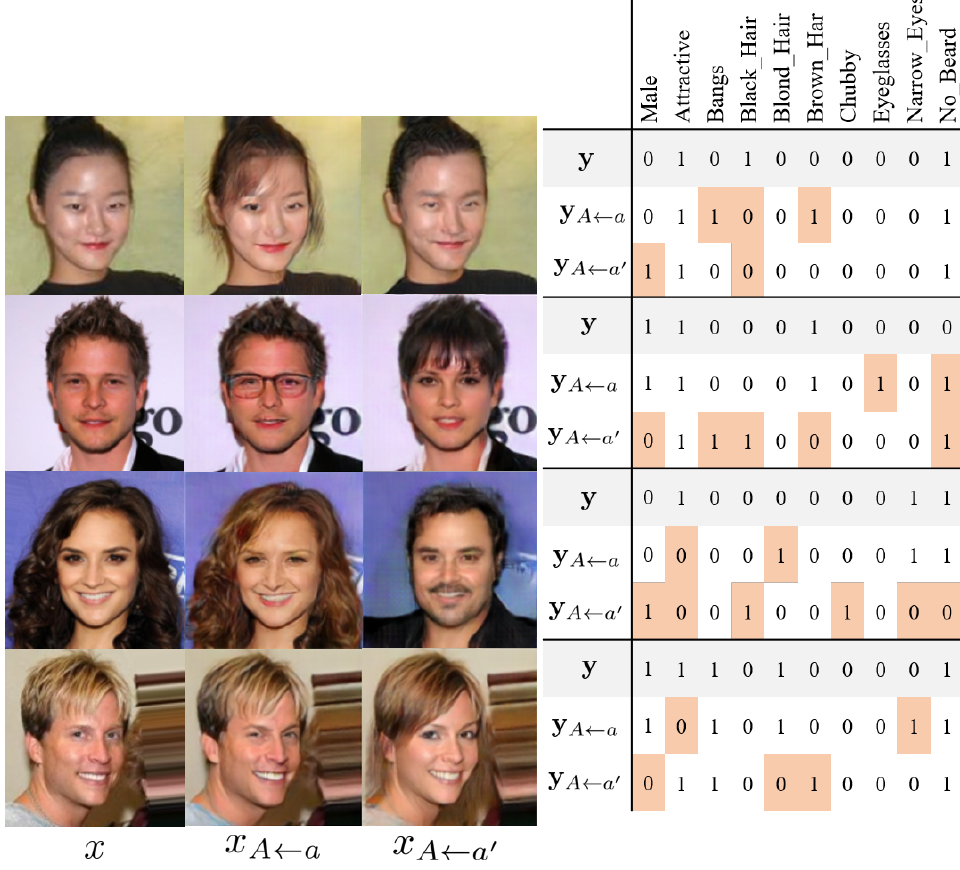
Figure 4. Observed and sampled images from intervention distribution on the gender. Nine of the twenty-nine target attributes and the sensitive attribute are visualized for y , y A ← a , and y A ← a (cid:48) . The gray and red cells indicate observed facial attributes and their values switched due to the interven- tions,